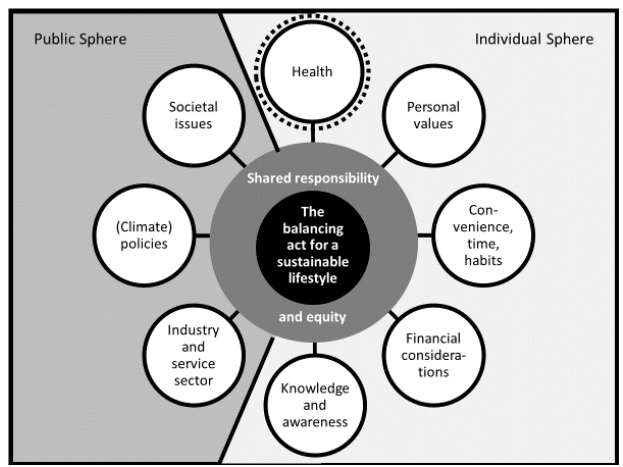
Figure 1. Themes and categories from the qualitative interviews. Table 3. Overview of subcategories, categories and overarching categories leading to themes.